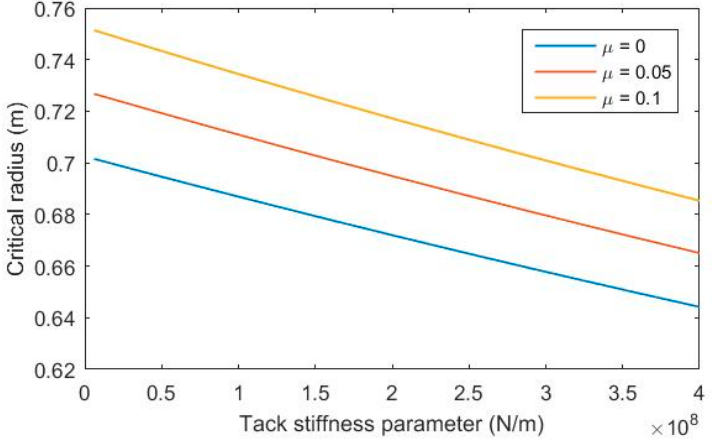
Figure 11. Critical radius steering variations with respect to tack stiffness parameter for different initial defect coefficients.